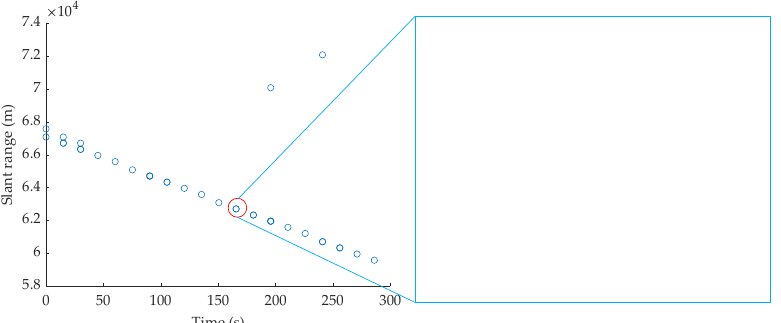
Figure 4. The range transformation of jamming with an enlarged view of radar main-lobe pulse sequence in a circle.